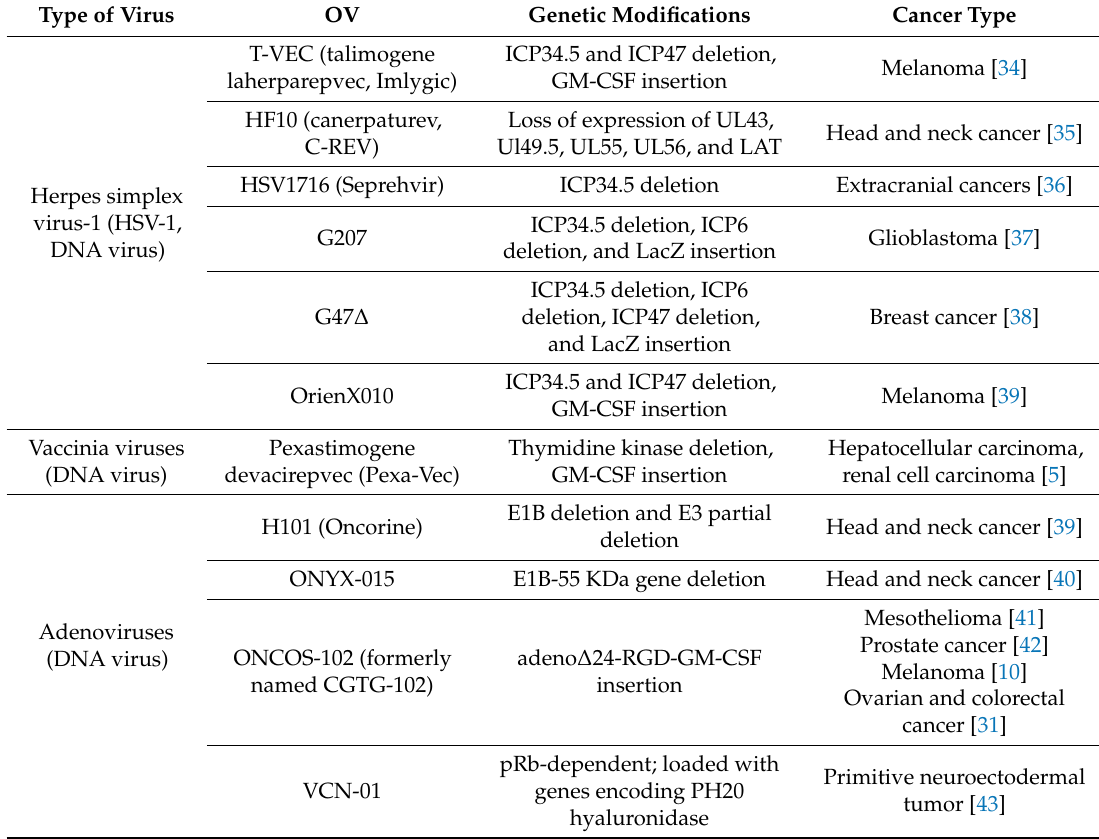
Table 1. Oncolytic viruses (OVs) under development (modified from Eissa et al. [33]). Type of